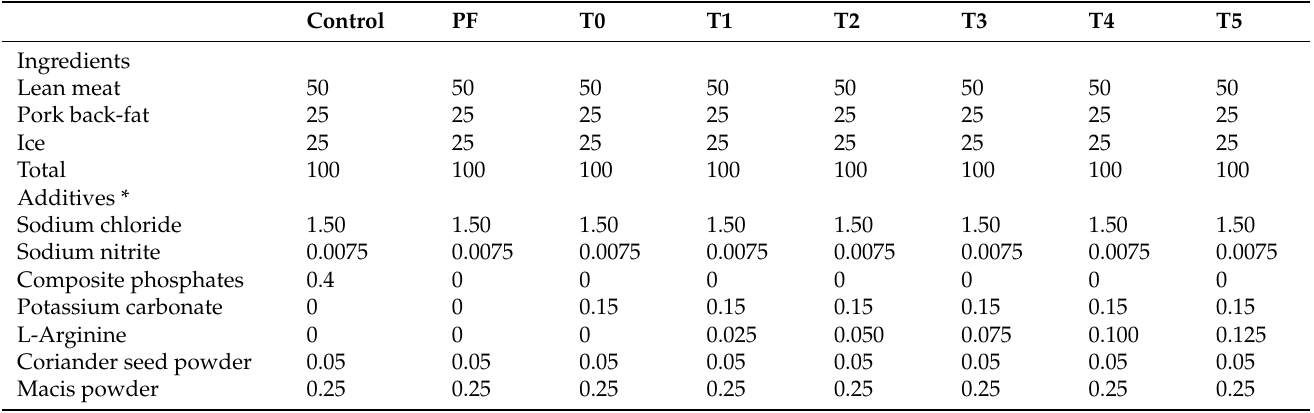
Table 1. Formulations (%) of phosphate-containing frankfurters or phosphate-free frankfurters added with the combination of L-Arginine (L-Arg) and potassium carbonate